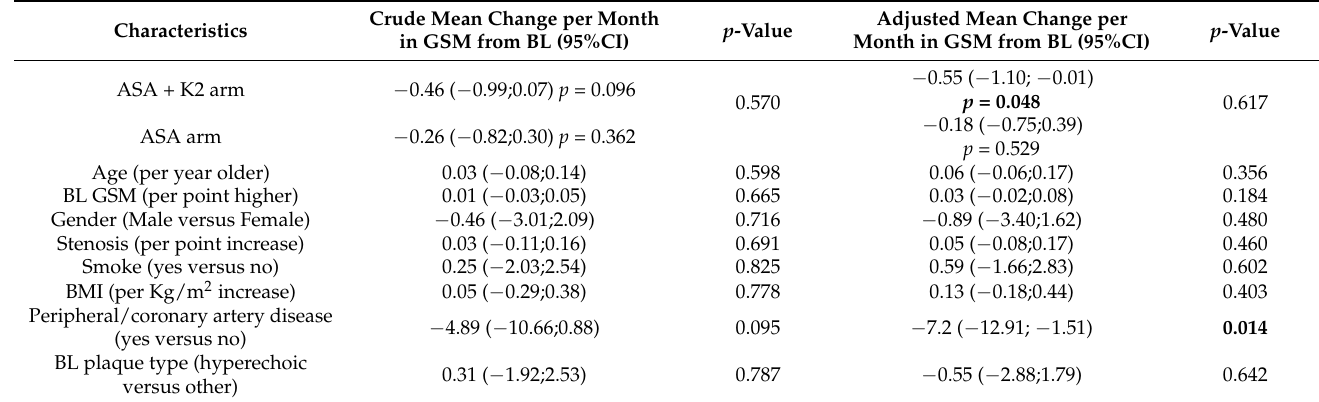
Table 3. Univariable and multivariable mixed linear models performed to assess baseline factors associated with mean monthly GSM change from baseline (BL). Statistically significant p -value (<0.05) are highlighted.